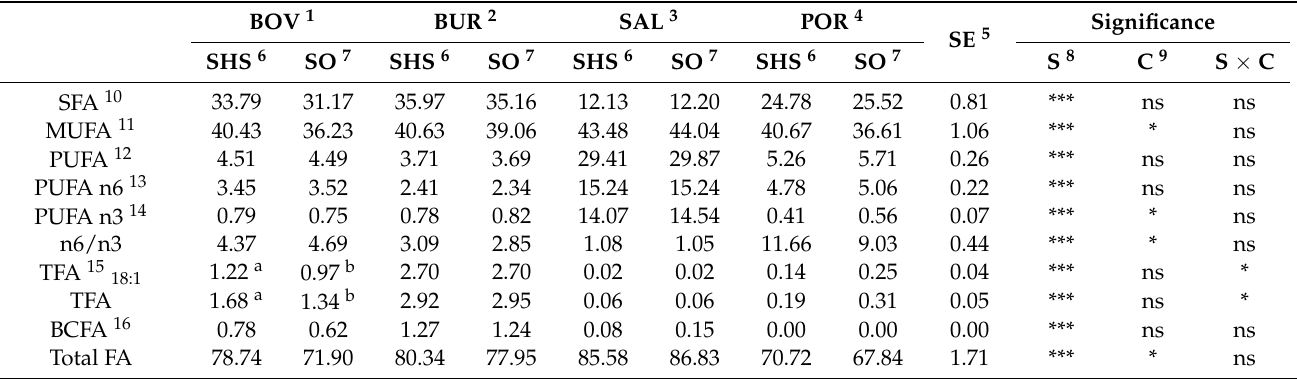
Table 5. Classes of the fatty acid composition of different matrices (g/100 g of total